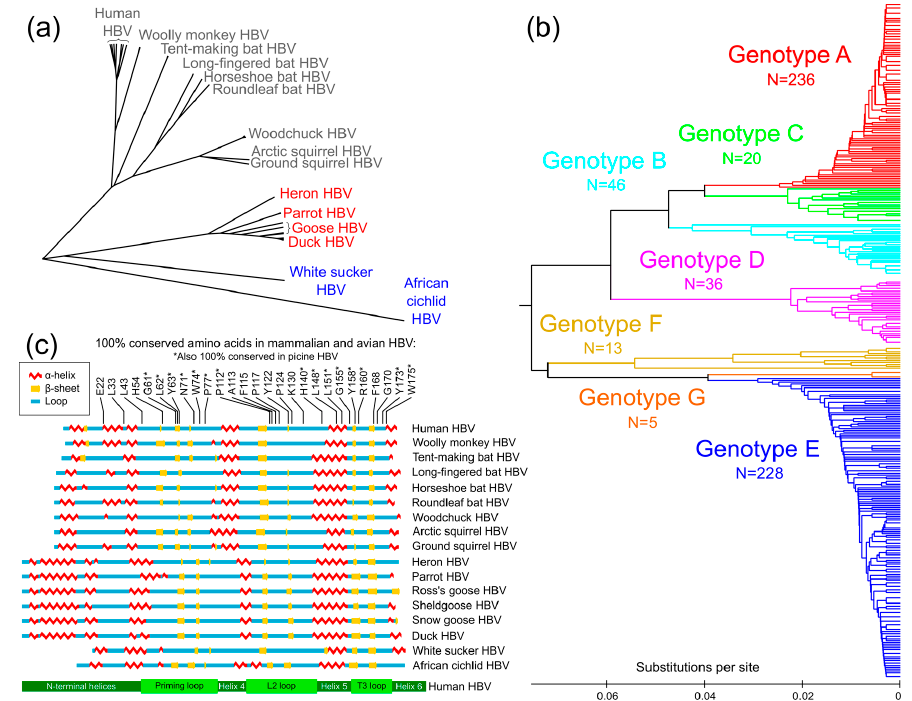
Figure 3. Evolutionary relationships and conservation among hepatitis B virus (HBV) isolates. ( a ) Amino acid sequences from 66 piscine (blue), avian (red), and mammalian (gray) HBV isolates were aligned and compared phylogenetically. Branch lengths represent the evolutionary distances between isolates of HBV that infect different host species. ( b ) Genotypes of human HBV isolates are grouped phylogenetically. Amino acid sequences from 584 human HBV isolates were compared, using reference sequences for genotypes A through G for determining genotype branching (colorized branches). Genetically identical isolates were consolidated into single lines. For both ( a ) and ( b ), the evolutionary history was inferred using the unweighted pair group method with arithmetic means. Trees are drawn to scale, with branch lengths in the same units as those of the evolutionary distances used to infer the phylogenetic tree. Evolutionary analyses were conducted in MEGA [55]. ( c ) Alignment of secondary structure predictions from representative HBV species of mammalian, avian, and piscine isolates. Alpha helices and beta sheets are shown for each sequence, and similar secondary-structure patterns were aligned based on three unstructured loops (regions between helices). The amino acid positions that are 100% conserved among mammalian, avian, and piscine HBV isolates are numbered and shown highlighted at the top, along the human HBV sequence for genotype D. A basic map of the subdomains of the human HBV TP domain is shown for reference, at the bottom in green.